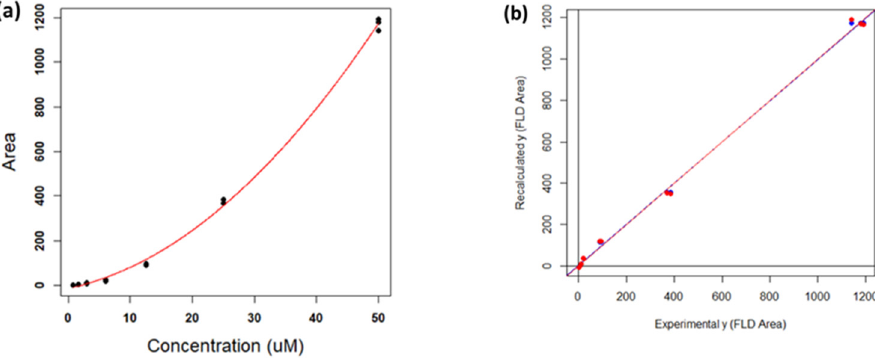
Figure 5. ( a ) Parabolic regression in the concentration range 0.8–50 µM. ( b ) Regression lines of the